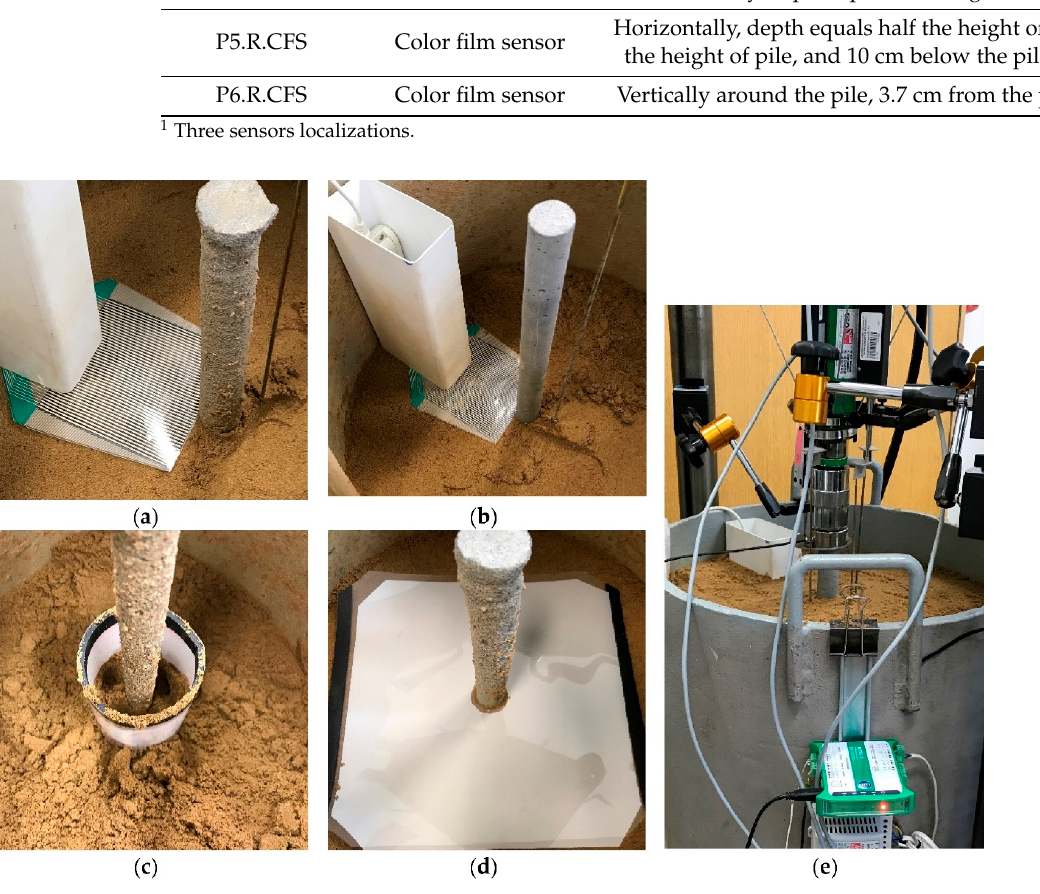
Figure 16. Photos of the laboratory stand with different measurement schemes. ( a ) The tactile sensor placed horizontally at the half of the pile depth P1.R.0.5H.TS. ( b ) The tactile sensor placed horizontally at the pile depth P2.S.H.TS. ( c ) The color film pressure sensor placed vertically around the pile P6.R.CFS. ( d ) The color film pressure sensor placed horizontally P5.R.CFS. ( e ) Laboratory stand prepared for the test.